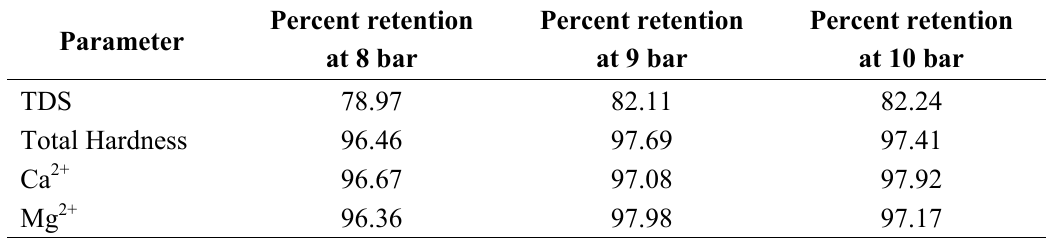
Table 4. Retention percentage (% R ) of TDS, total hardness, Ca 2+ and Mg 2+ at various pressures for Sample 1.